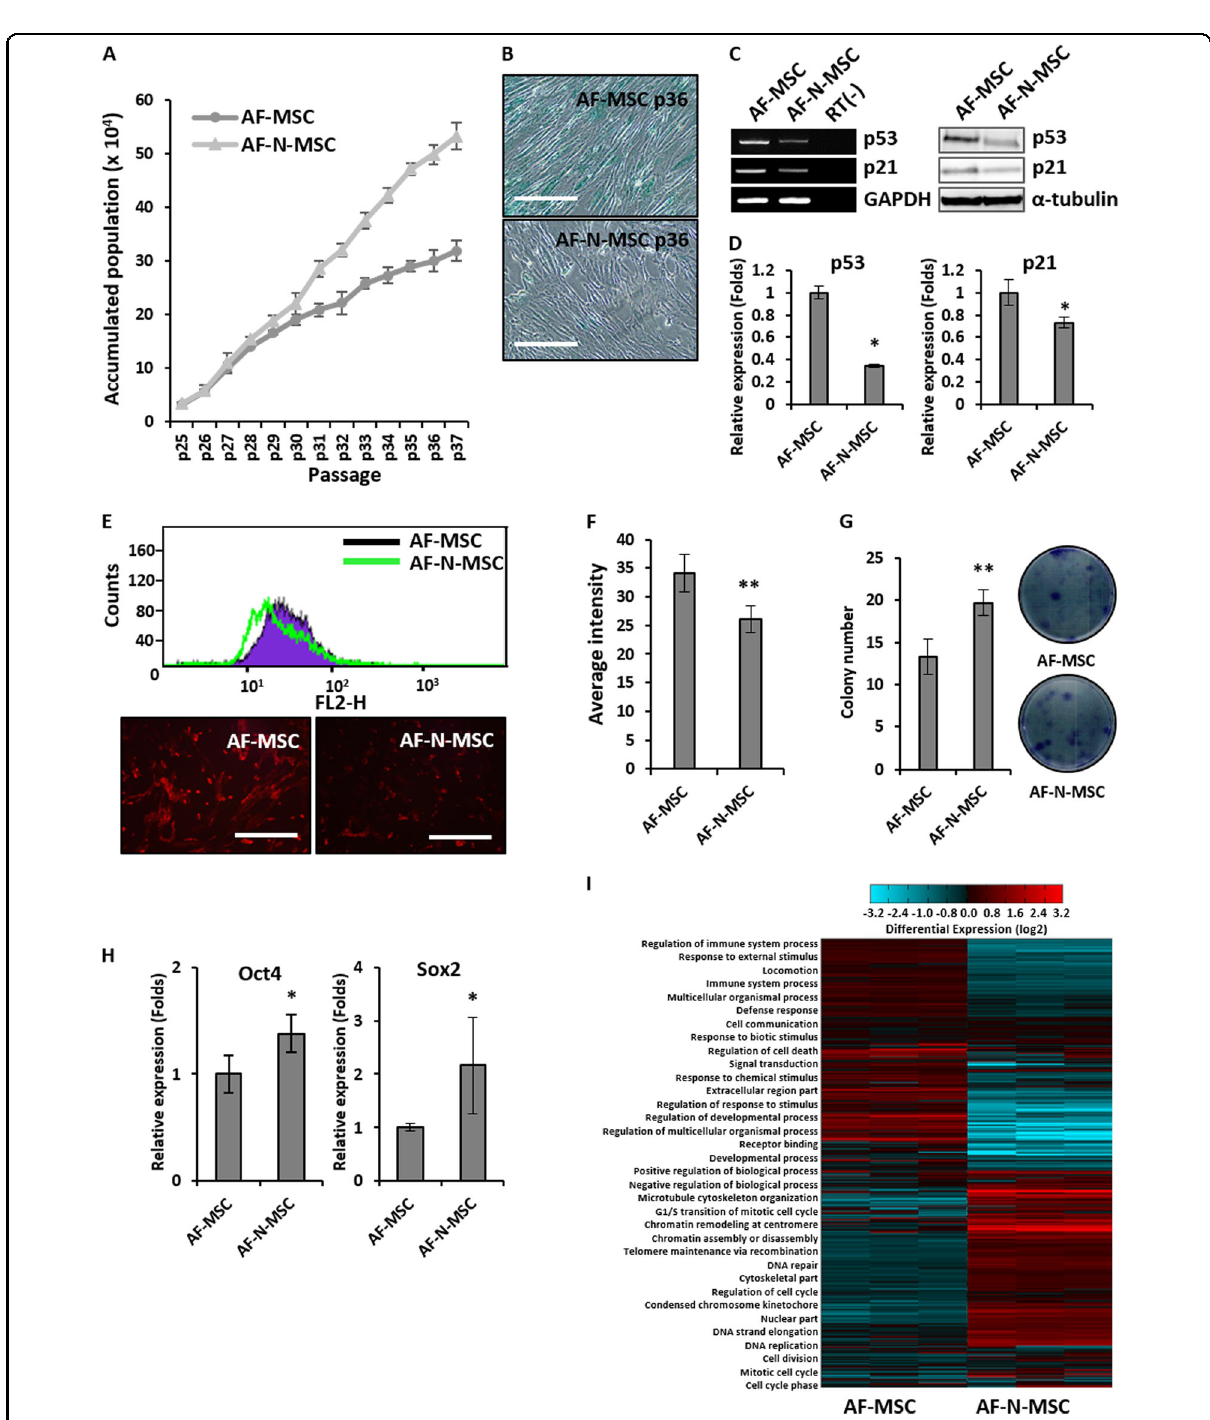
Fig. 2 Promotion of amniotic fl uid – derived mesenchymal stem cell (AF-MSC) stemness by Nanog overexpression. a Growth rate of AF-MSCs overexpressing Nanog (AF-N-MSCs). Non-modi fi ed AF-MSCs served as a control (AF-MSCs). b β -Gal staining of AF- and AF-N-MSCs in passage 36. Scale bar, 200 µm. c mRNA (left) and protein expression (right) of senescence-related genes in AF- and AF-N-MSCs. d Quanti fi cation of p53 and p21 expression by quantitative real-time reverse transcriptase – polymerase chain reaction (qRT-PCR). e Fluorescence-activated cell sorting analysis and DHE staining to detect reactive oxygen species (ROS) accumulation in AF- and AF-N-MSCs. Scale bar, 1 mm. f Quanti fi cation of fl uorescence intensity for ROS accumulation. g Colony-forming unit fi broblast analysis for evaluation of AF- and AF-N-MSC stemness. h Changes in endogenous expression of the pluripotency-related transcription factors (Oct4 and Sox2) in AF-MSCs upon Nanog overexpression. Expression levels were measured by RT-PCR and qRT-PCR. i Hierarchical clustering analysis of gene expression in AF- and AF-N-MSCs. Data are represented as the mean ± SD ( n = 3). * p < 0.05; ** p <